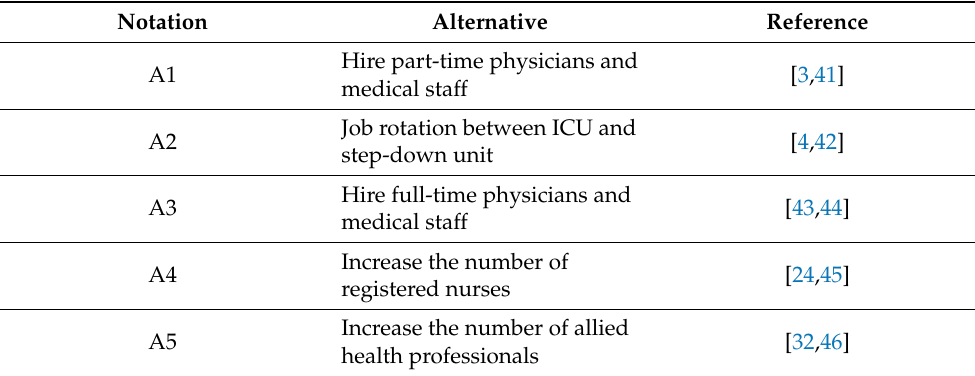
Table 2. List of alternatives or strategies for improving ICU service